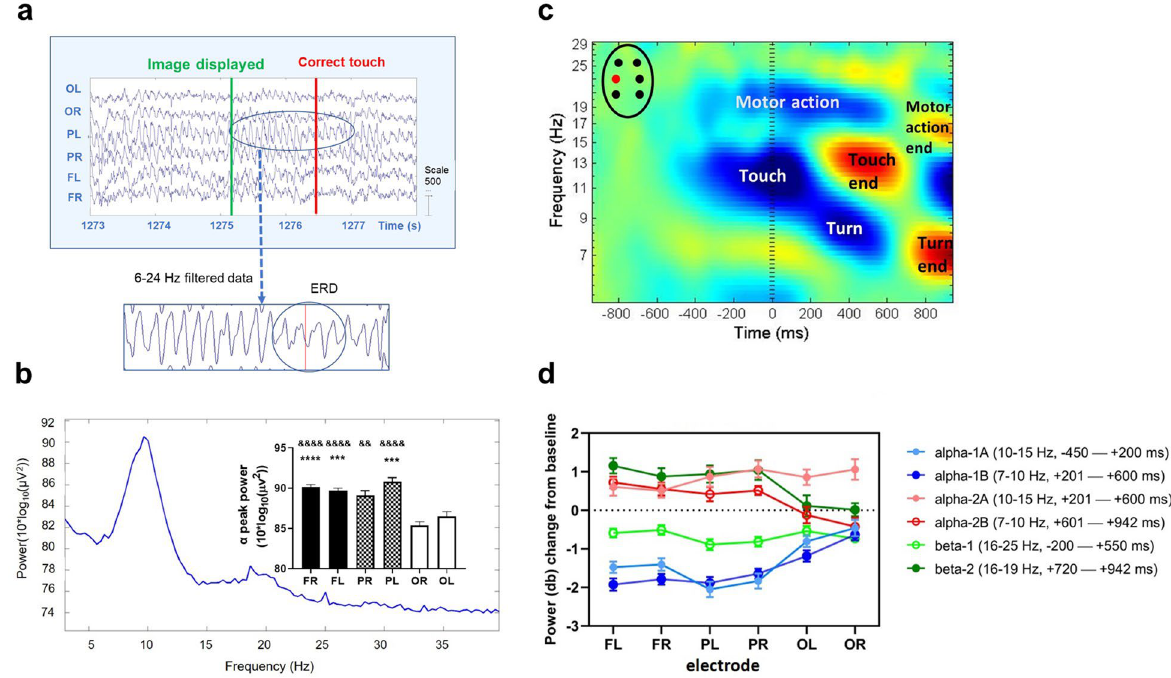
Figure 2. Drug-free analysis: alpha and beta oscillatory dynamics in the normal brain. ( a ) Raw EEG data around a typical correct epoch. Image presentation was followed by a burst of arciform alpha configuration predominating over the parietal left (PL) electrode. Arciform waveforms emerged in the alpha range during image presentation, then alpha desynchronization appeared right before and over the course of the touch. The 6–24 Hz filtered segment more specifically illustrates the region of interest. ( b ) FFT spectra. The plot represents a dominant peak in the alpha (9–10 Hz) and a smaller amplitude beta peak (18–20 Hz) of correct epochs at the PL electrode. The graph shows the frontoparietal dominance of alpha power at the peak (mean ± SEM) over each electrode. && p < 0.01 and &&&& p < 0.0001: significant multiple comparisons tests compared to OR channel; *** p < 0.001 and **** p < 0.0001: significant multiple comparisons tests compared to OL channel. ( c ) ERSP map of correct touches at the PL electrode. Plots show the mean time course of ERSP power (decibel, db) change relative to the baseline in the period from ~ 1000 ms before to ~ 1000 ms after correct touch responses (t = 0) in the frequency range of 5–30 Hz averaged across all subjects (n = 16) treated with vehicle; motor functions associated to the ERD and ERS cycles were denoted. The ERSP map were created by the EEGLab toolbox of MatLab. ( d ) Spatial distribution of ERSP power during correct responding. Graph show ERSP change from baseline in all relevant time–frequency windows (db, mean ± SEM; represented by coloured lines) at each electrode in correct epochs. The magnitude of power changes showed frontoparietal dominance in all cycles except for alpha-2A and beta-1, which spread evenly across the cortex. Abbreviations: FL frontal left, FR frontal right, PL parietal left, PR parietal right, OL occipital left, OR occipital right